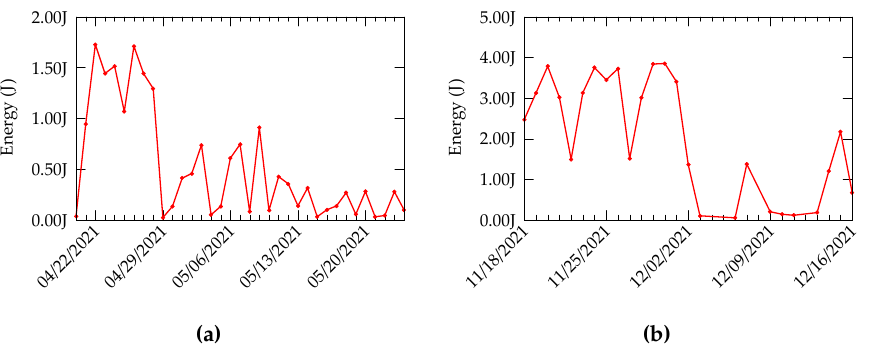
Figure 5. Energy estimation based on data collected from CDE and Forhot sites ( a ) Estimated values for CDE. ( b ) Estimated values for